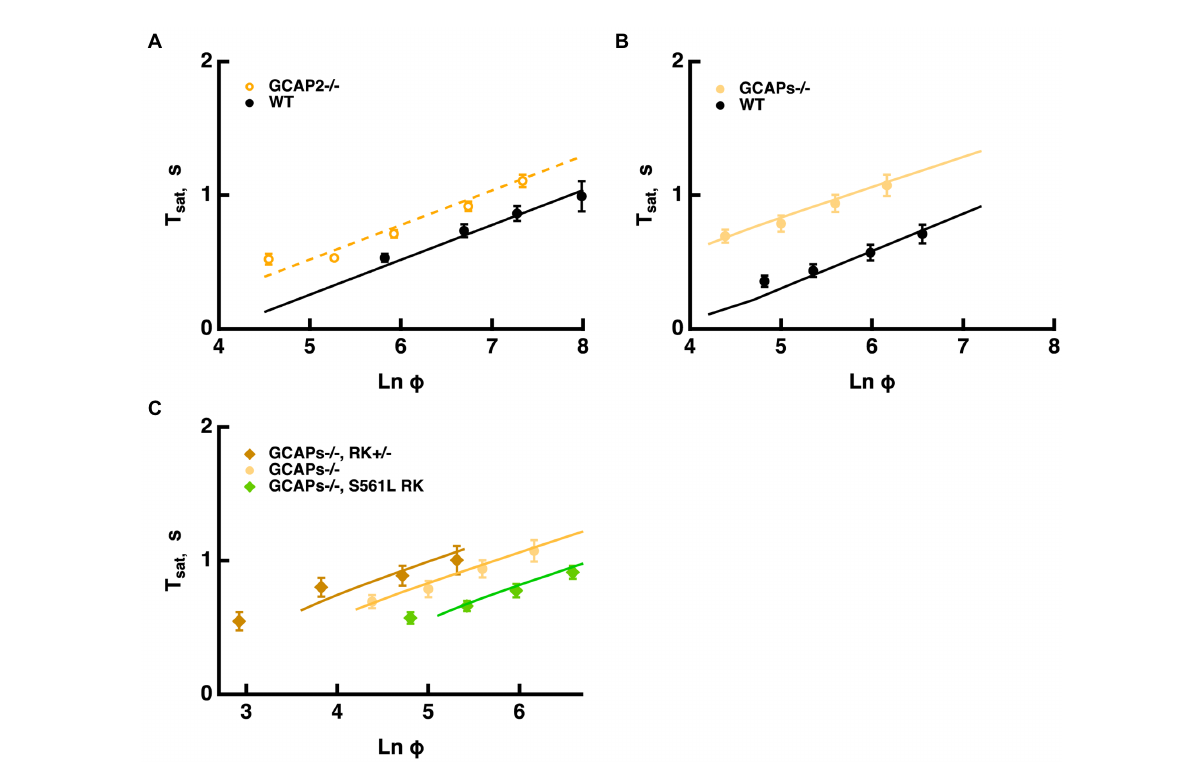
FIGURE 7 Longer T sat without a change in slope of the Pepperberg relation upon reduction of Ca 2+ -dependent ROS-GC activity. (A) Pepperberg plots for GCAP2 knockout and wild type rods. Results were from Makino et al. (2008); T sat was measured from mid-flash to 20% recovery. (B) Pepperberg plots for GCAPs knockout and wild type rods. Results were from Gross et al. (2012); T sat was measured from mid-flash to 10% recovery. (C) Pepperberg plots for mutant RK rods from Figure 6 but on a GCAPs knockout background. For the parameter set used, the model did not yield saturating responses for the double mutants at the lowest Ln ( Φ ) values used experimentally. Results were from Gross et al. (2012); T sat was measured from mid-flash to 10%